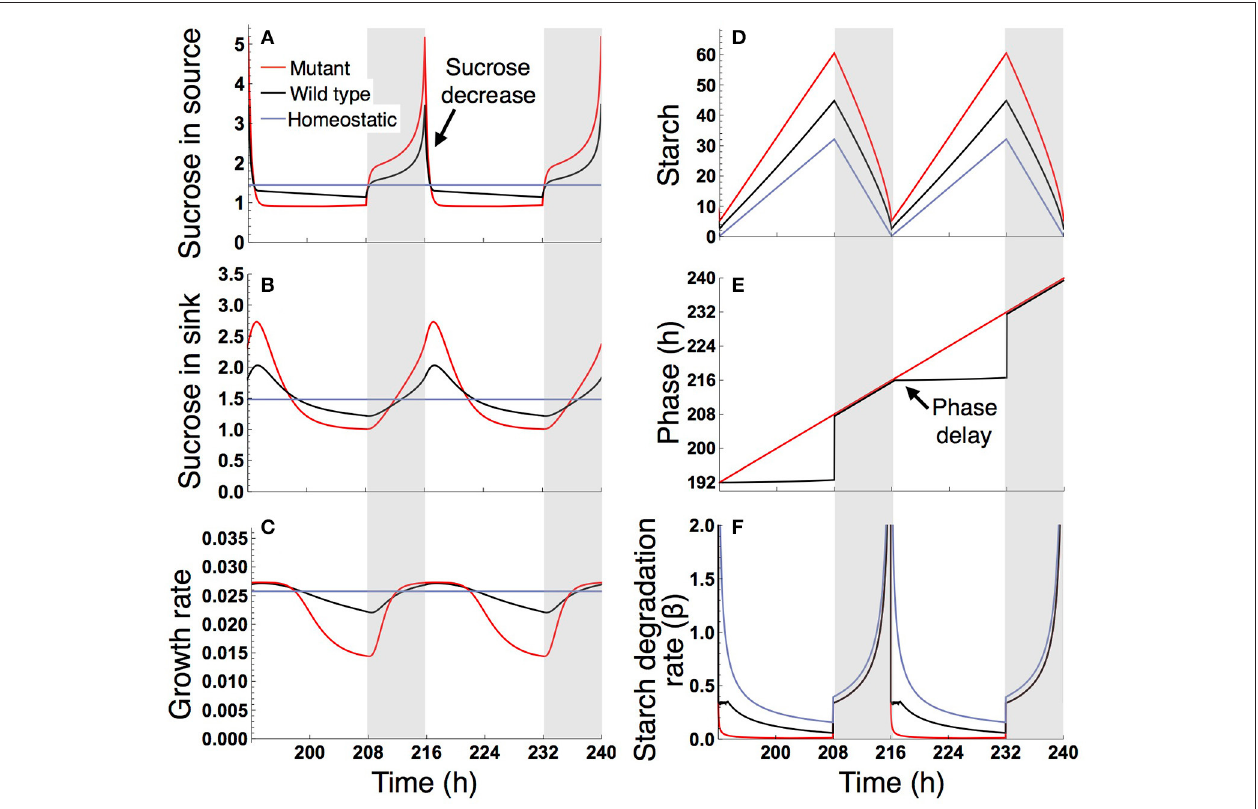
FIGURE 4 | Predicted profiles of (A) sucrose in the source, (B) sucrose in the sink (SAM or RAM), (C) growth rate of the sink (SAM or RAM), (D) starch, (E) phase, and (F) starch degradation rate of the plants grown in a 16-h photoperiod. The unit for sucrose and starch is µ molC 6 g − 1 FW. White background, light period; Gray background, dark